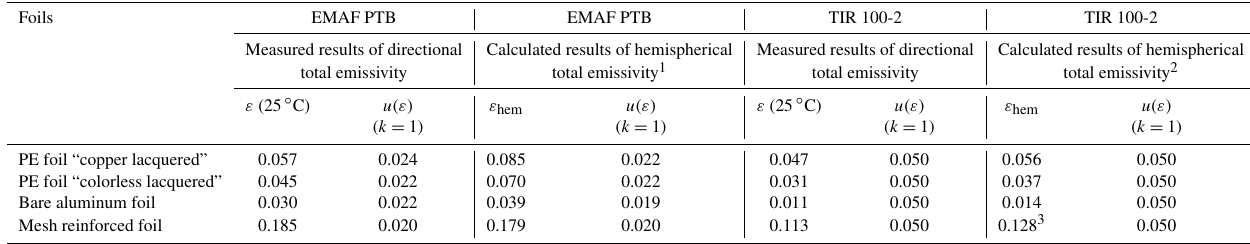
Table 6. The data of the measured directional total emissivity and the calculated hemispherical total emissivity of the foils performed by the EMAF at PTB in the wavelength range from 5 to 20µm and the TIR 100-2 in the wavelength range from 2.5 to 40µm. Foils